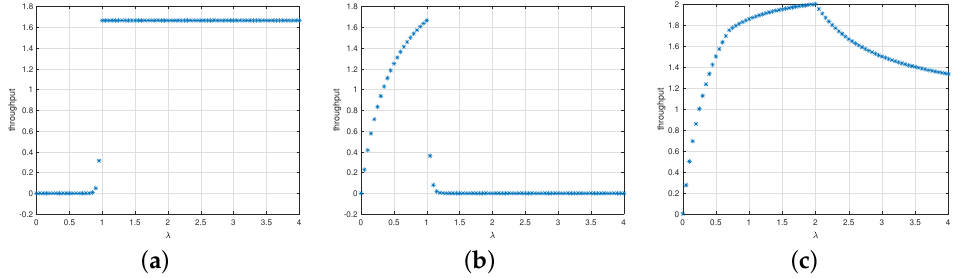
Figure 11. Equilibrium throughput properties of the MTS TCPN model in Figure 1b. ( a ) Disconti- nuity of the equilibrium throughput for parameter λ 5 . ( b ) Non-monotonicity with deadlock of the equilibrium throughput for parameter λ 2 . ( c ) Non-monotonicity without deadlock of the equilibrium throughput for parameter λ 2